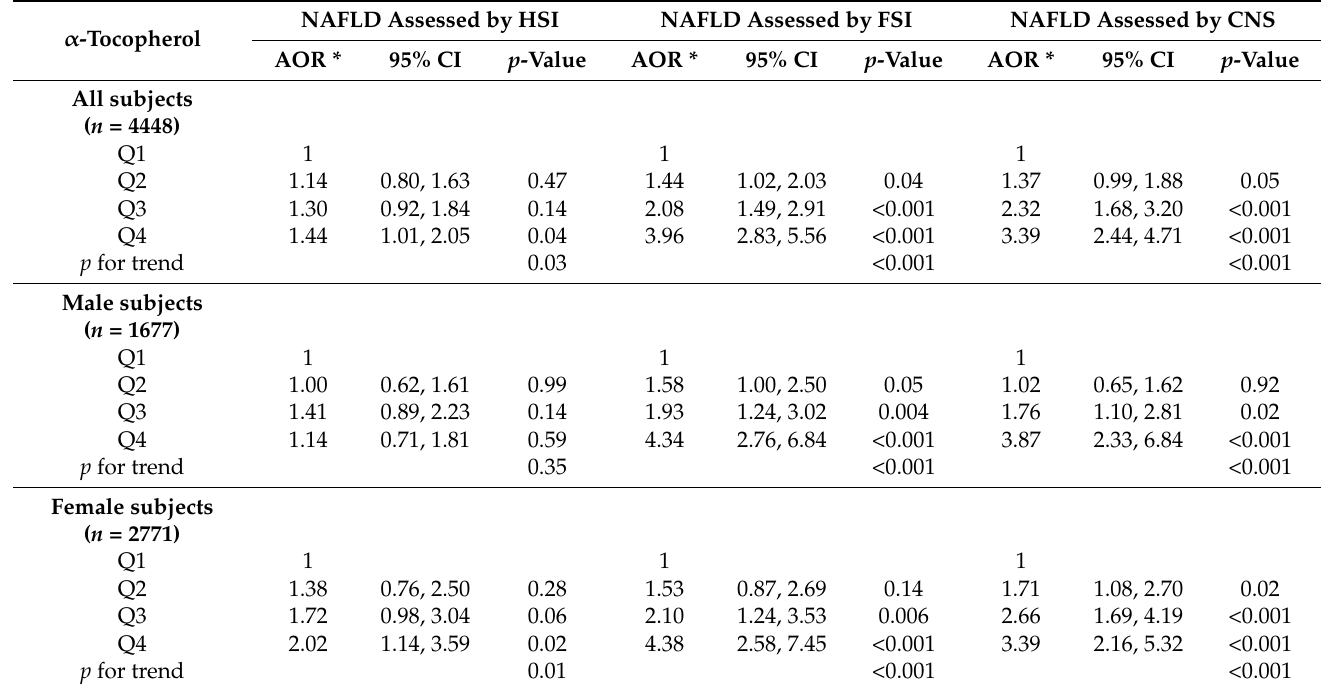
Table 4. AORs with 95% CIs for association between α -tocopherol and NAFLD assessed using different prediction models. α